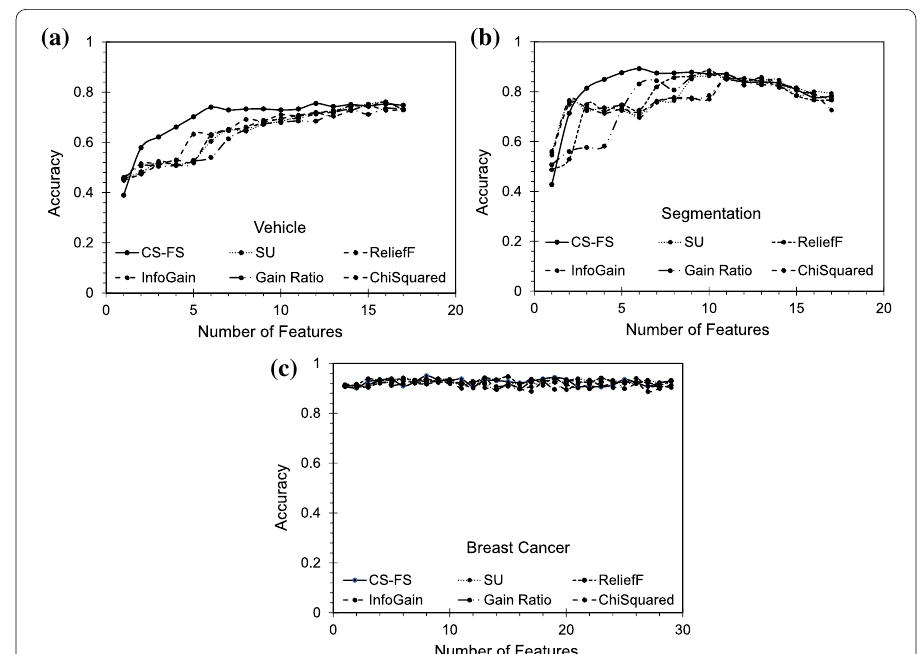
Fig. 4 Comparison of the complex-step sensitivity method with other feature selection methods for the classification